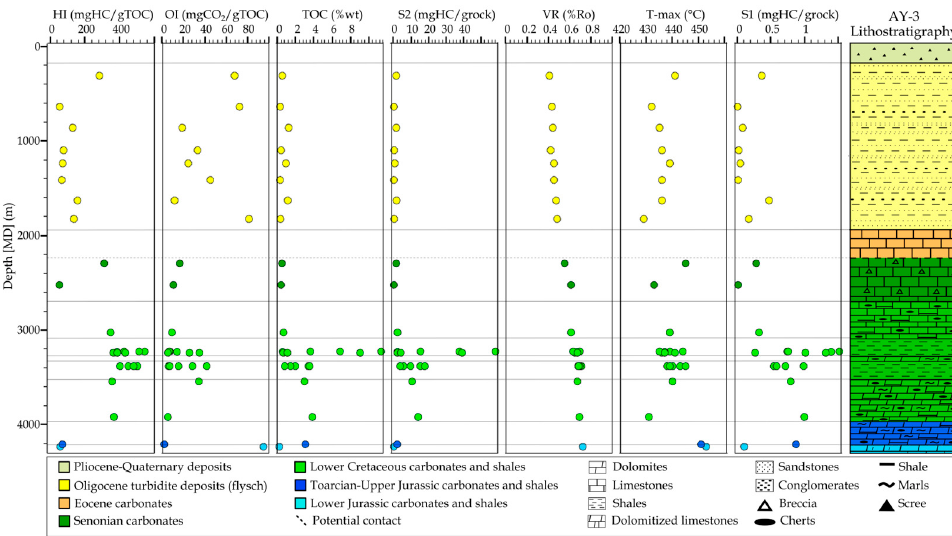
Figure 5. Multi-depth plot illustrating several geochemical parameters; Tmax, S1,S2,HI,OI,TOC, with measured depth, related to the simplified stratigraphic column of the well AY-3. The units of the included parameters are shown on the figure and are discussed in chapter 3.2.1. The different colors incorporated are related to the stratigraphy of the well, illustrated on the right-hand side.